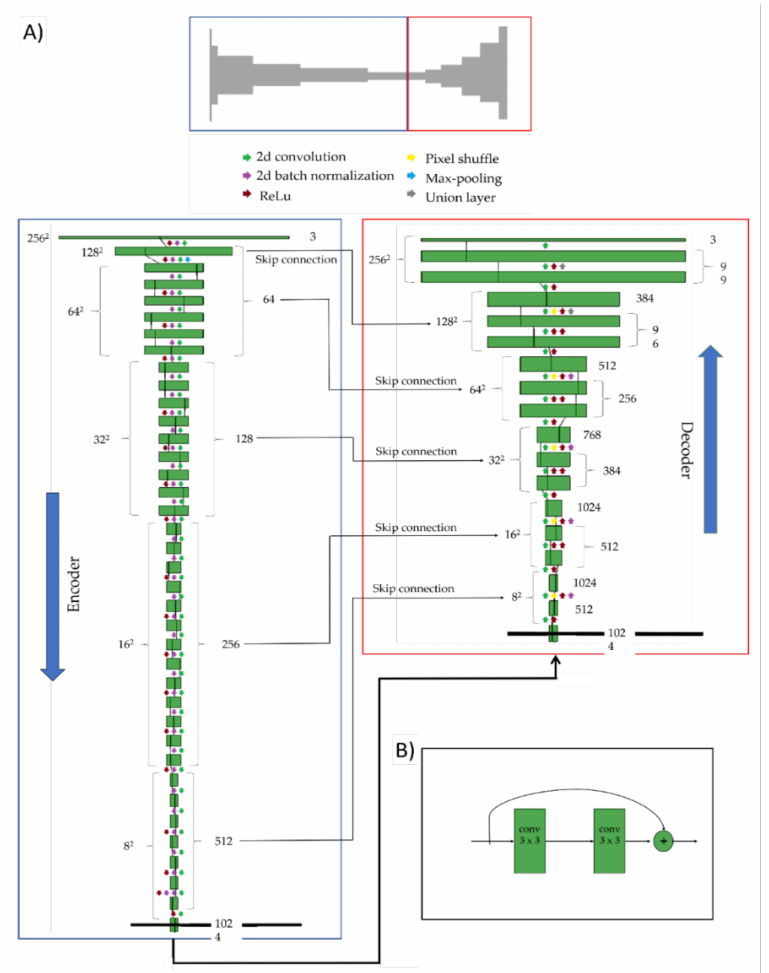
Figure 4. Dynamic U-Net model used for semantic segmentation. ( A ) The encoder consists of a ResNet-34 into which the orthomosaic and UGS labeling information is integrated. The numbers on the left of the graphs are the sizes of the input and output images, and the sizes of the activation maps. The numbers on the right are the channels/filters. ( B ) Building blocks used in the encoder section of the